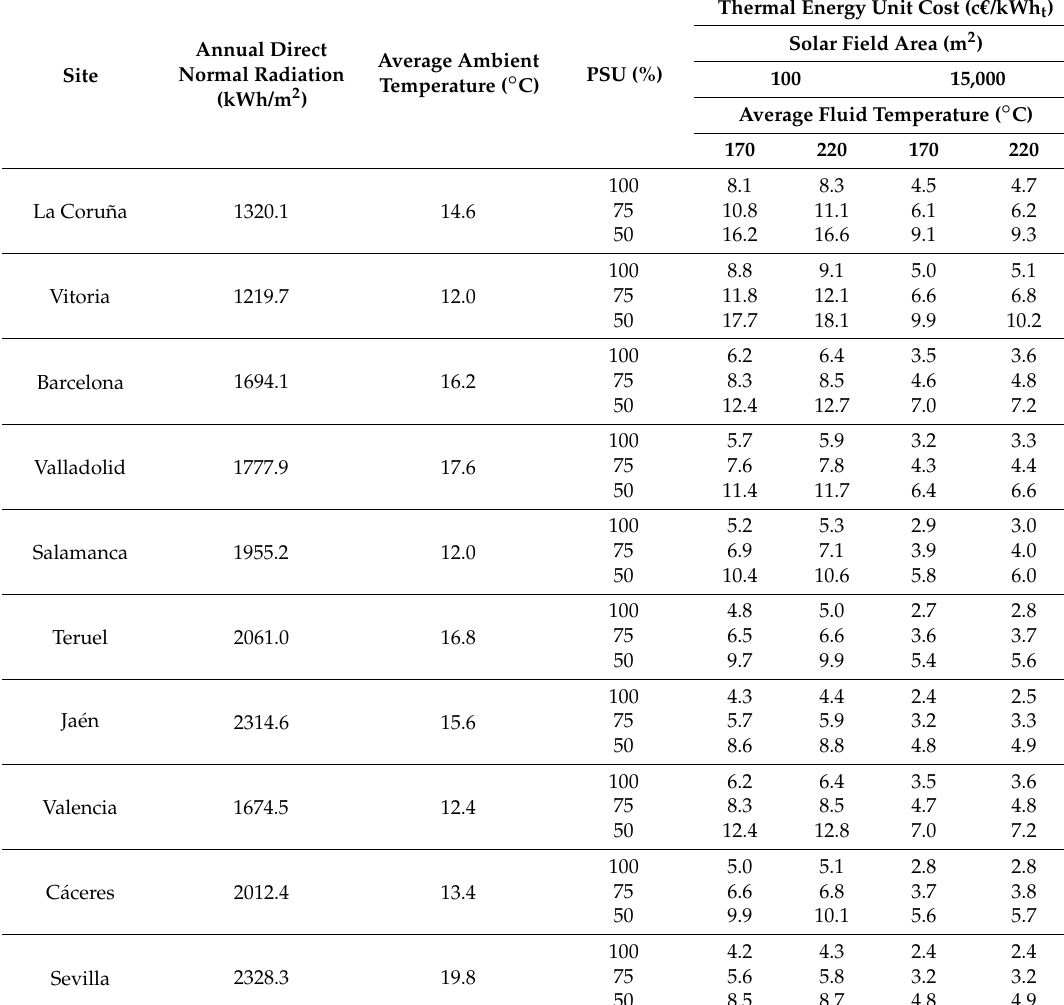
Table 22. Thermal energy unit cost, LFC technology.